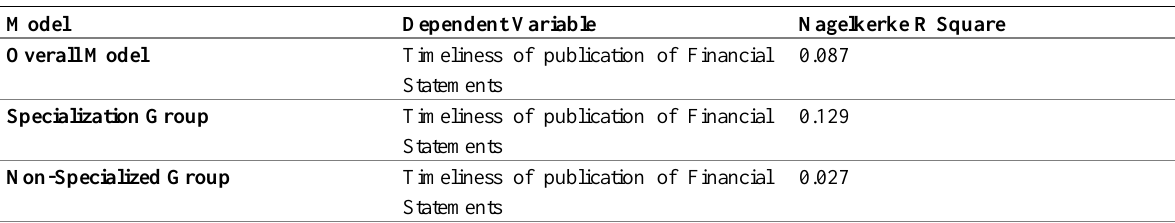
Table 6: Coefficient of Determination